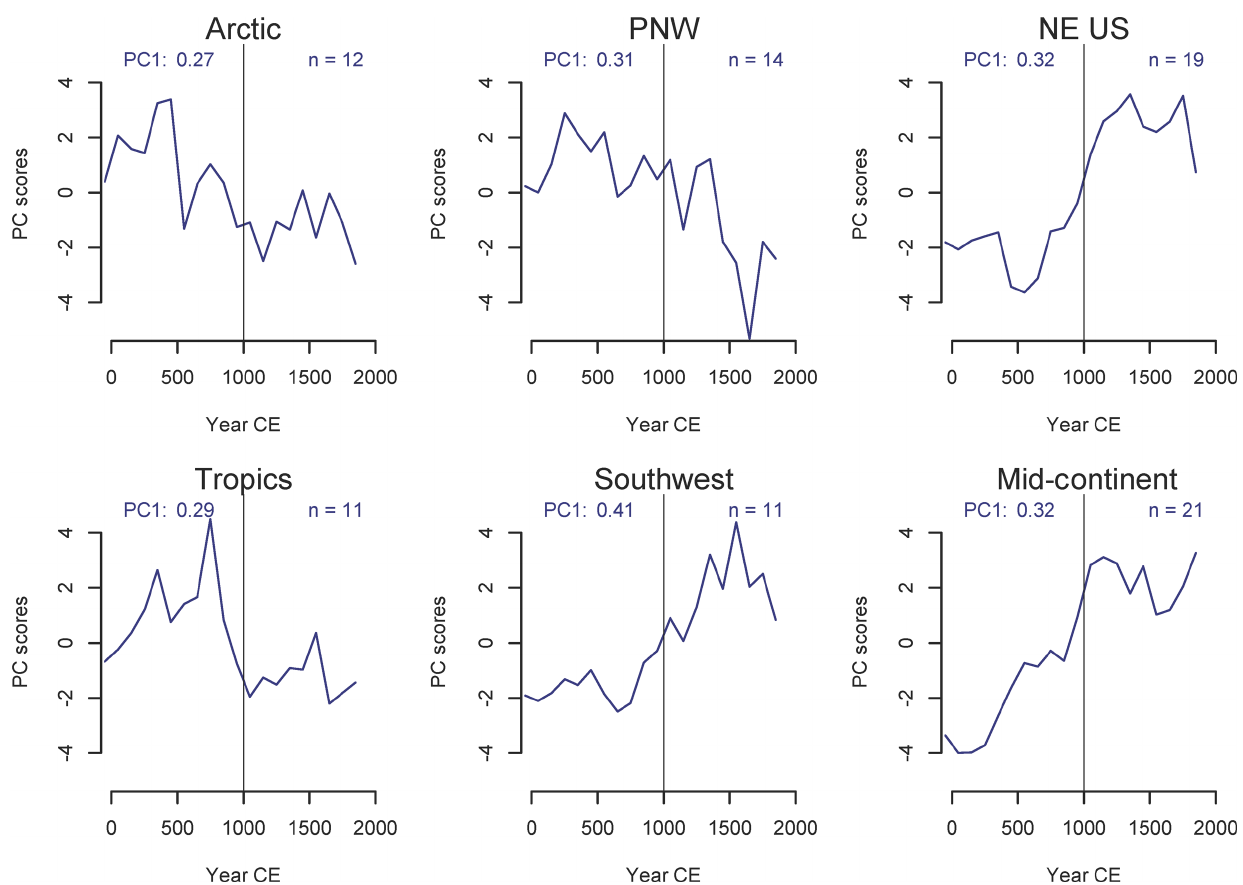
Figure 6. Regional principal component analysis (PCA) scores showing the dominant modes of variability in six North American hydrocli- mate regions delineated in Fig. 1. Numbers on the left represent the fraction of the variance explained by PC 1 in each region. Vertical lines mark